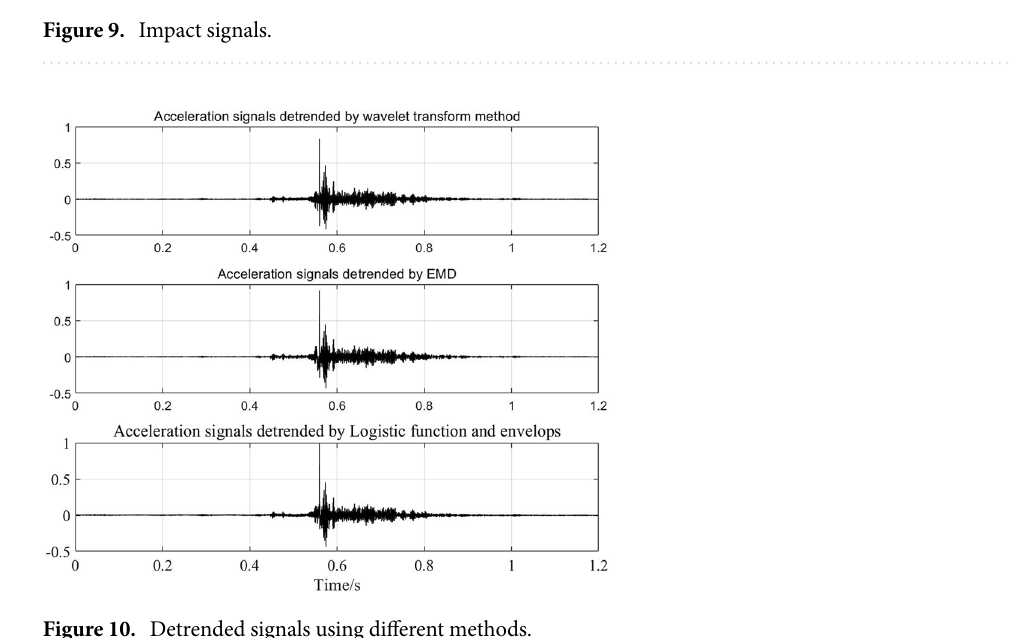
Figure 10. Detrended signals using different